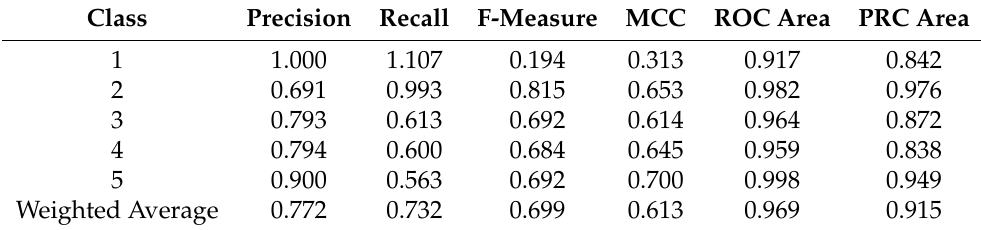
Table 20. CS-Forest Accuracy